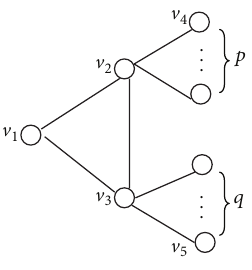
Figure 2: The graph 𝐺 1 (𝑝,𝑞) .